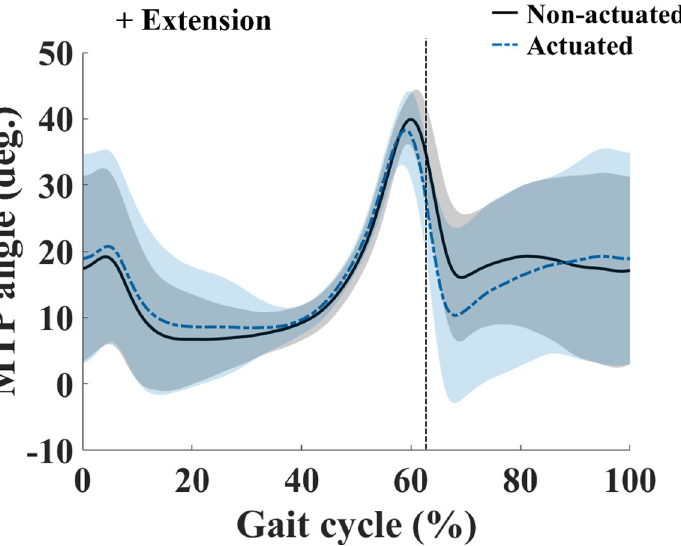
Fig 7. MTP angle over one gait cycle. Curves are averages taken over all participants; shaded regions indicate one standard deviation. The vertical lines indicate the toe-off.